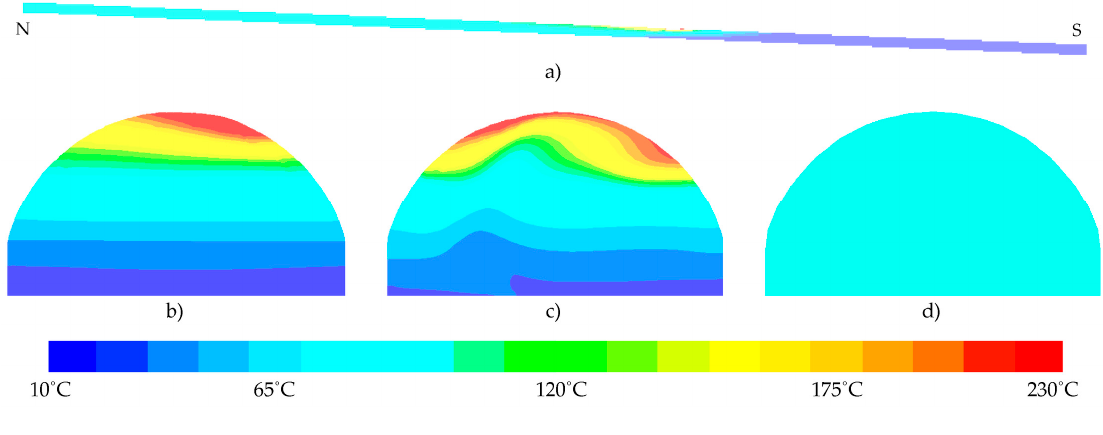
Figure 15. Temperature distributions for fully developed car fire at entire tunnel symmetry plane ( a ), two cross-sections at a distance of 5 m from fire source: ( b ) on windward, ( c ) on leeward and ( d ) on N portal.